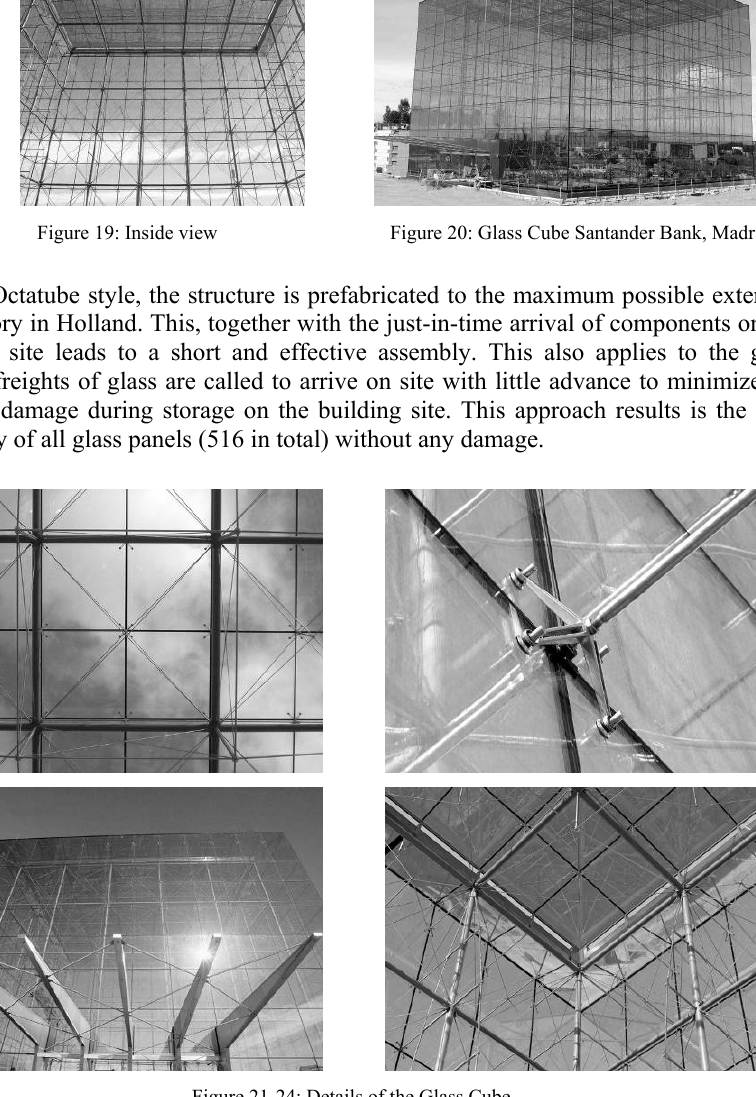
Figure 21-24: Details of the Glass